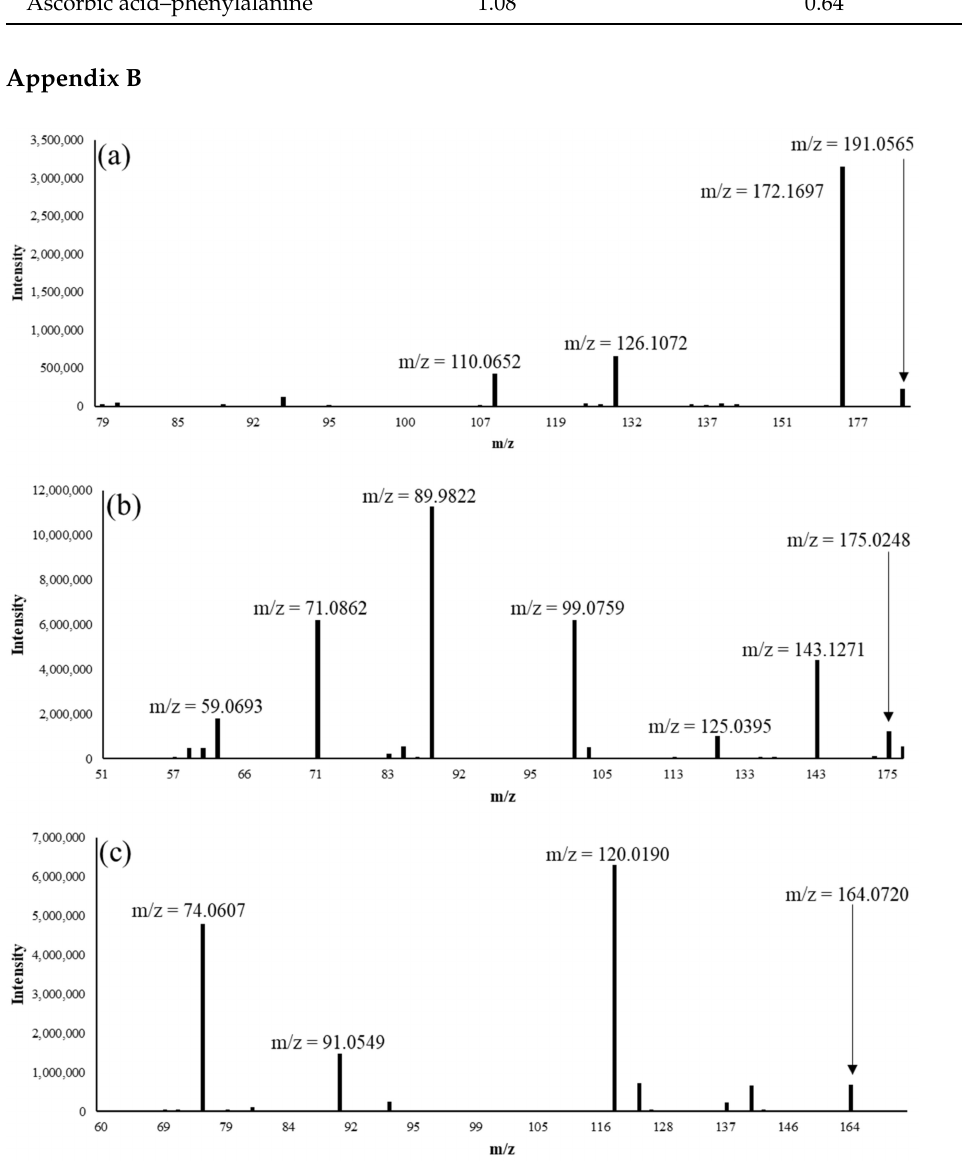
Figure A1. Fragmentation spectra of ( a ) quinic acid, ( b ) ascorbic acid, and ( c ) phenylalanine obtained by